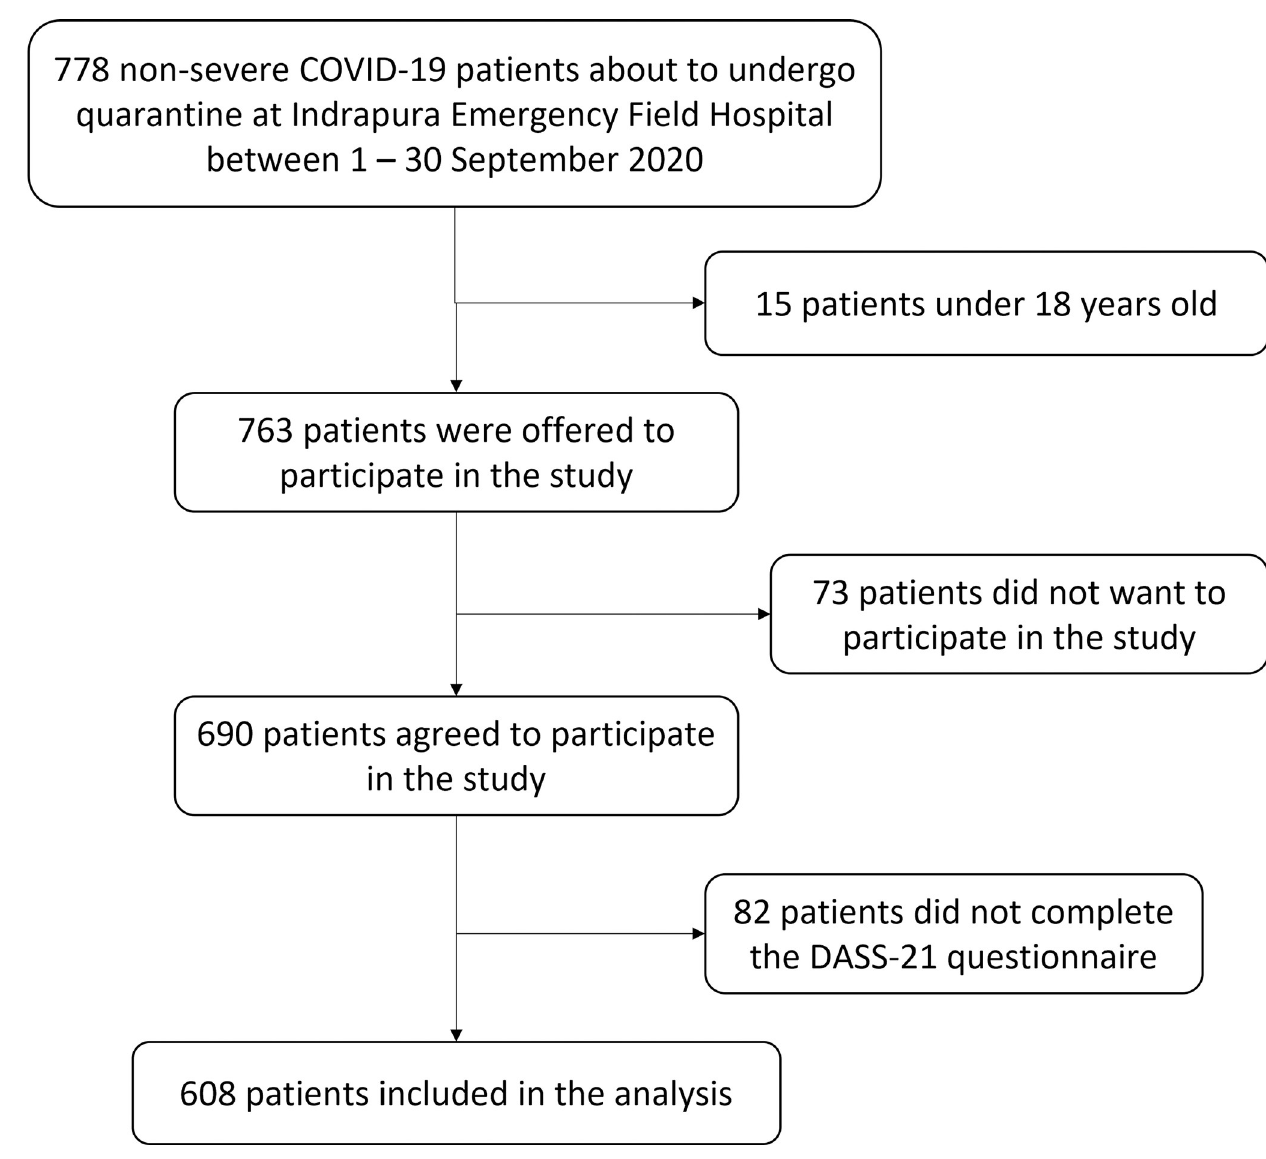
Fig 1. Flow diagram of study